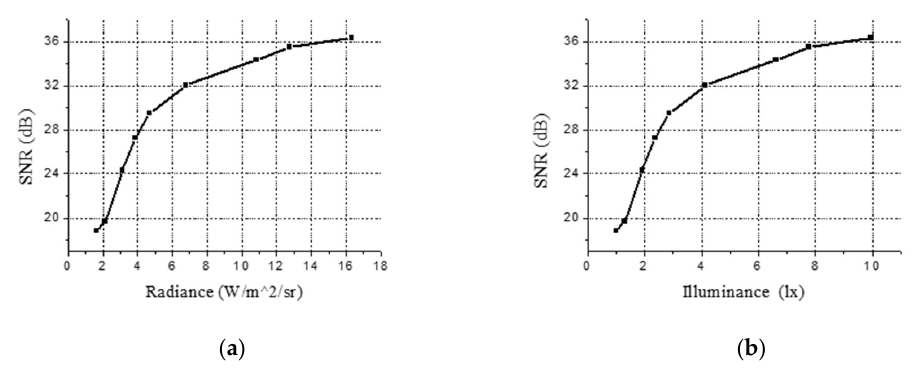
Figure 18. SNR(signal to noise ratio) tested results of the images. ( a ) the relationship between SNR and radiance of optical entrance; ( b ) the relationship between SNR and illuminance of targets with reflectivity of 0.3 and atmosphere’s transmittance of 0.6.